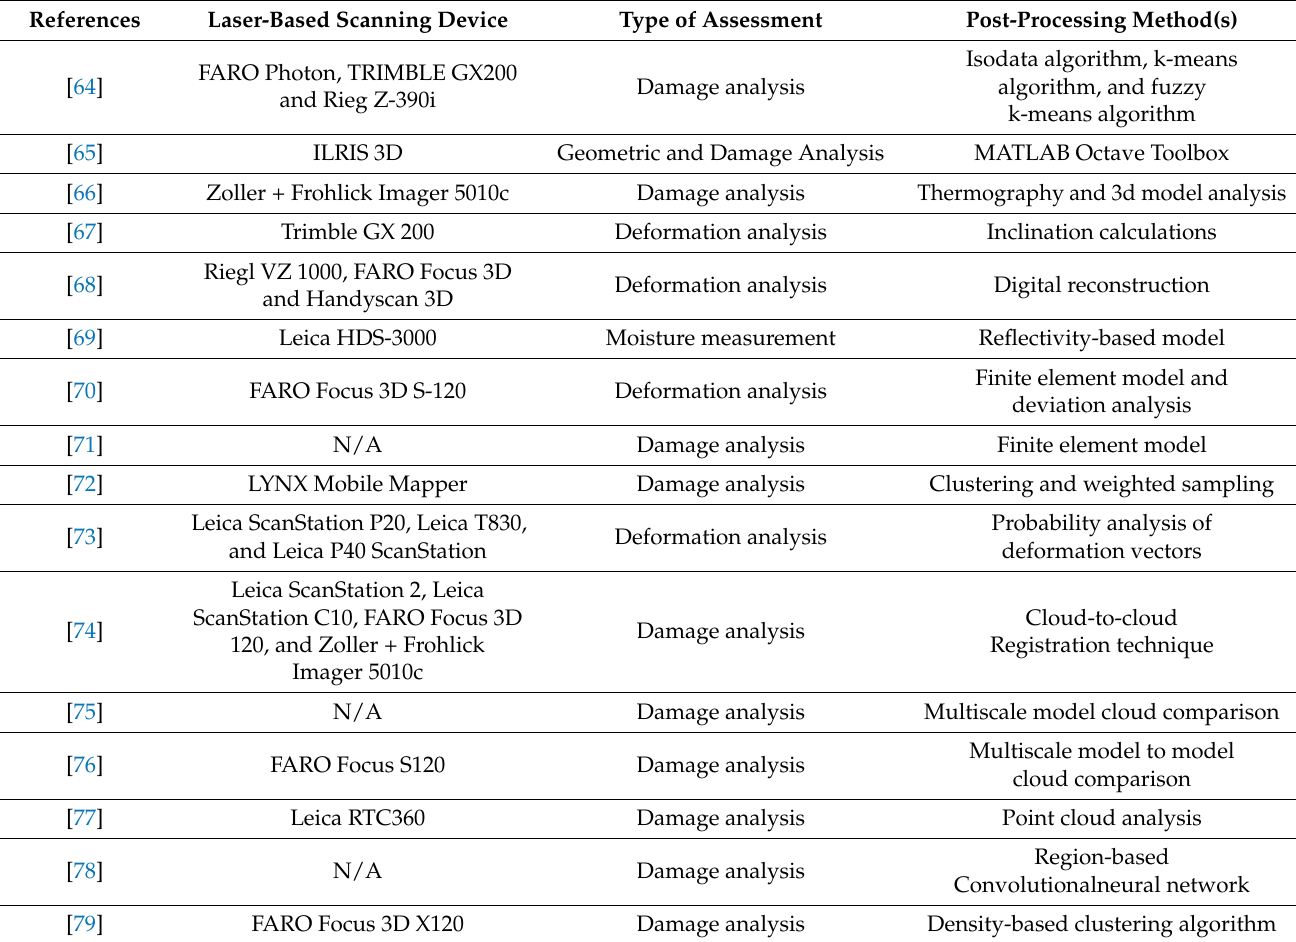
Table 5. A comprehensive summary of laser-based assessment techniques for historic